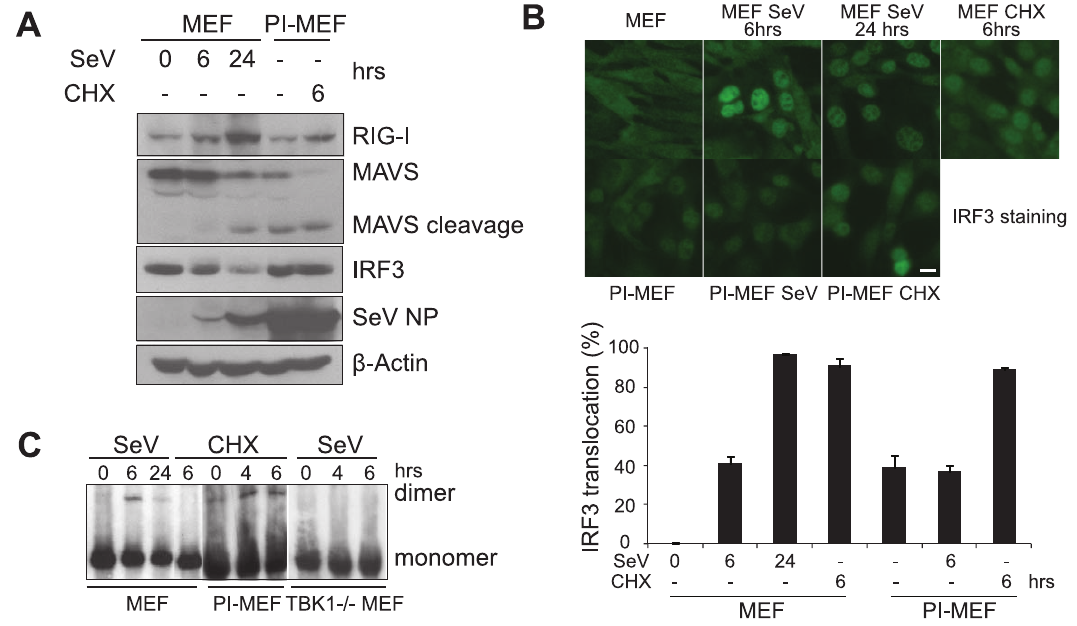
Figure 4. Regulation of IFN b activation pathway signaling molecules in PI-MEFs. A . Expression of RIG-I, MAVS , IRF3, SeV NP and b -Actin in PI-MEFs. Control MEFs infected with SeV for the indicated times and PI-MEFs before and after CHX treatment were harvested; whole cell lysates were prepared and separated by SDS-PAGE, and western blots probed with antibodies specific for the indicated proteins. B . Subcellular localization of IRF3 in control MEFs and PI-MEFs infected with SeV, or treated with CHX. Cells were subjected to various treatments for indicated time, and fixed for IRF3 staining. The percentage of cells (out of , 150 cells) with nuclear IRF3 staining under different conditions was determined and shown below the images. Data represent at least three independent experiments. Scale bar,10 m m. C . IRF3 dimerization in virus infected MEFs and CHX treated PI- MEFs. Control MEFs were infected with SeV, PI-MEFs were treated with CHX for indicated time. Total cell lysates were prepared and subjected to native gel electrophoresis and probed with IRF3 antibodies. TBK1 knockout MEFs were also infected with SeV in parallel for a negative